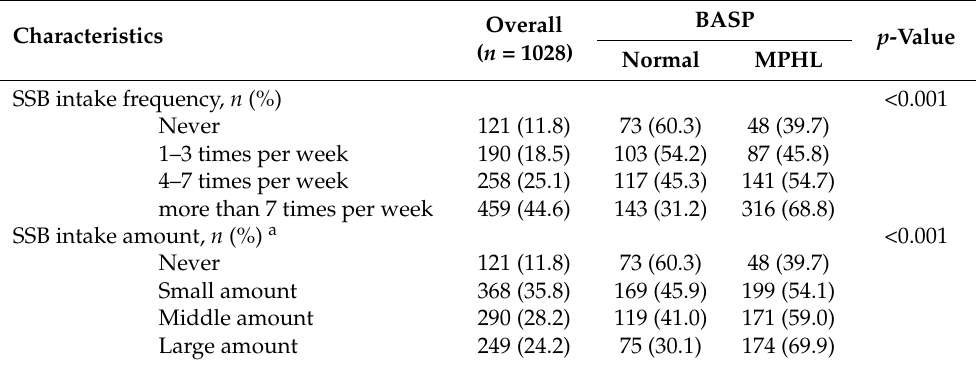
Table 3. Sugar-sweetened beverages (SSBs) consumption in past month among participants with and without male pattern hair loss (MPHL).